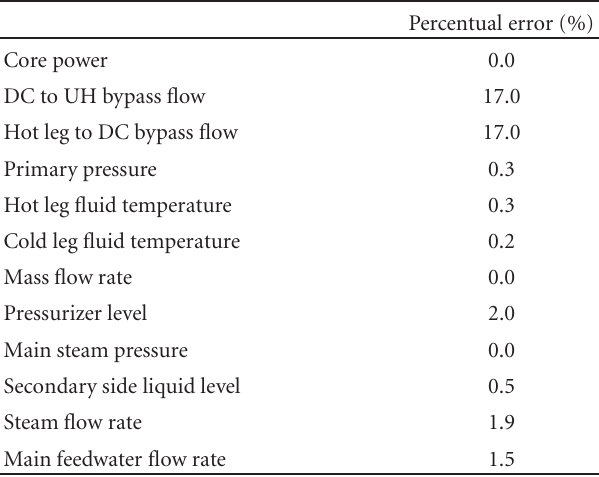
Table 1: Percentual error between the calculated steady state and the experimental